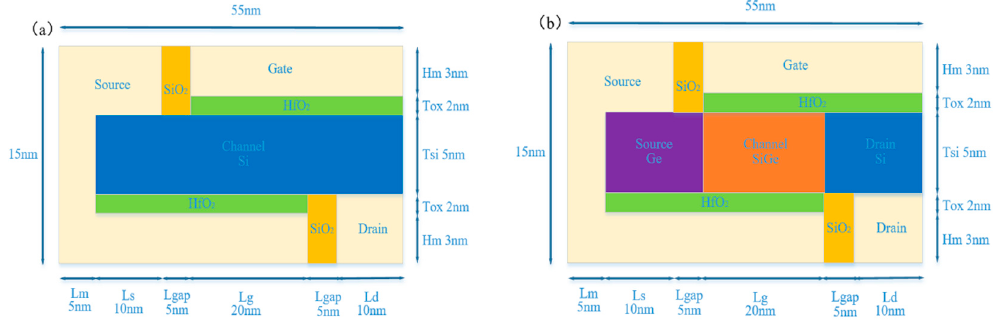
Figure 1. Schematic diagrams of ( a ) a conventional tunneling field-effect transistor (DLTFET) and ( b ) the new proposed doping-less tunneling field-effect transistor with Si 0.6 Ge 0.4 heterojunction (H-DLTFET).